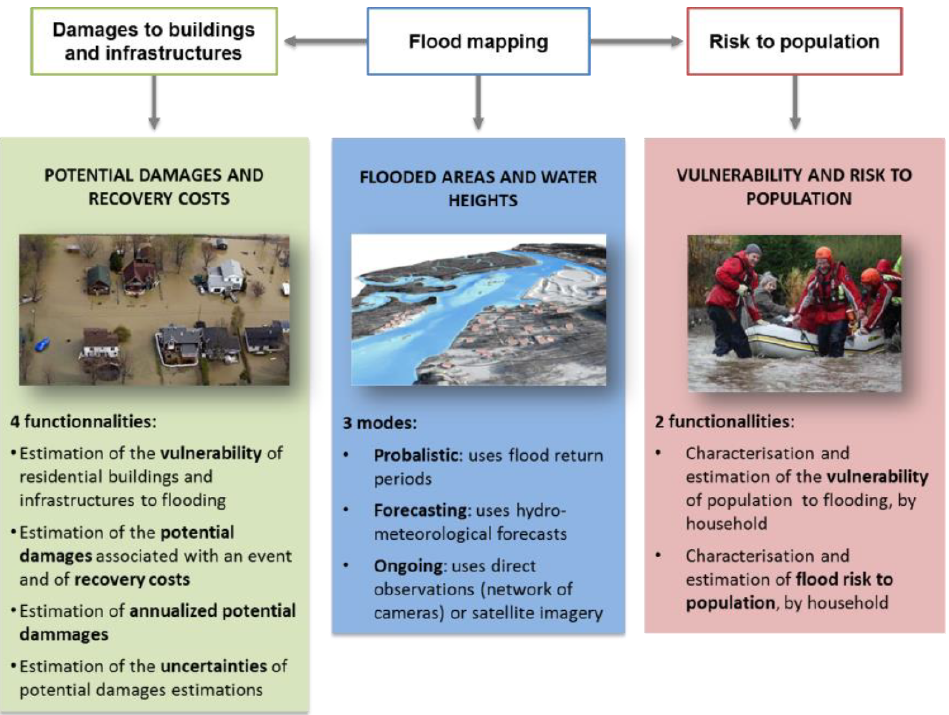
Figure 2. Modes and functionalities of the GARI tool.